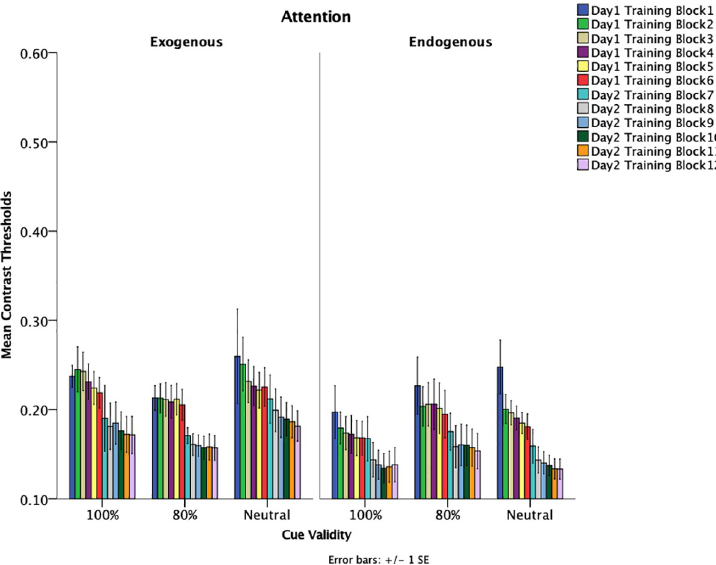
Fig 6. Mean contrast thresholds for training data as a function of cue-validity and attention. Blocks 1–6 were on training day 1 and blocks 7–12 were on training day 2. Error bars indicate +/- 1 standard error.